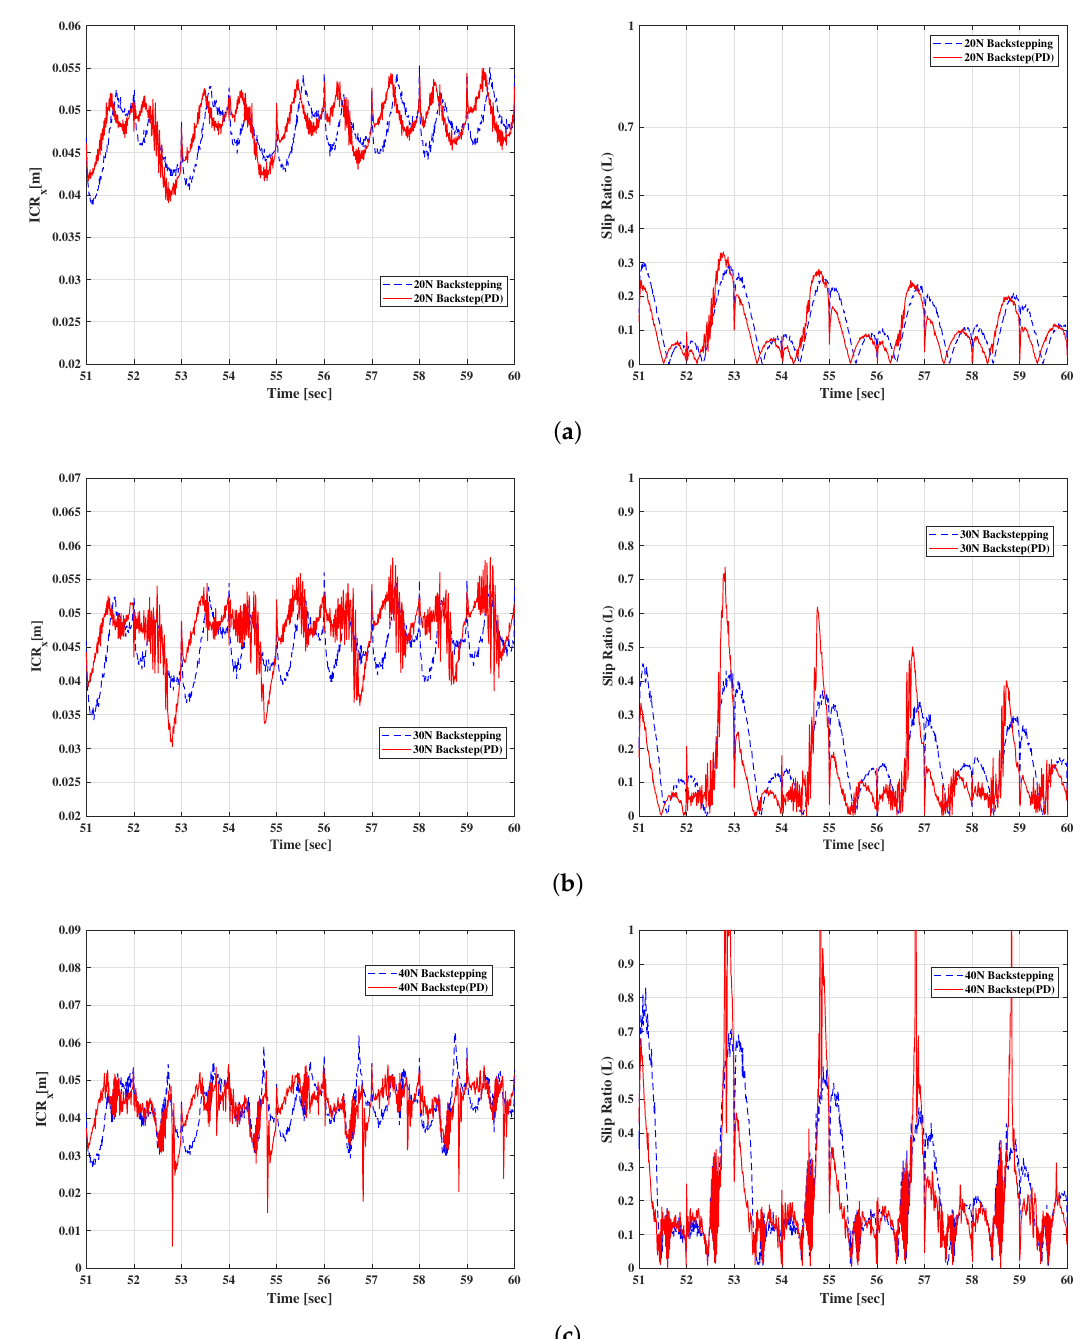
Figure 10. Position of the ICR x and front-left wheel slippage with variable brush interaction force. ( a ) Force = 20 N; ( b ) Force = 30 N; ( c ) Force = 40